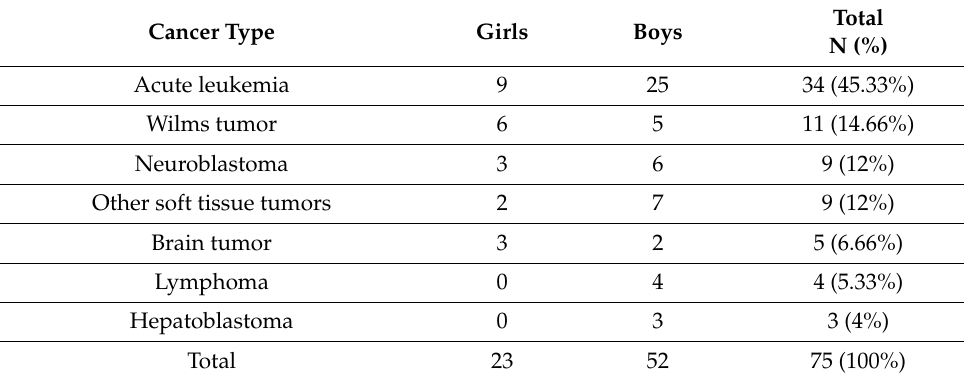
Table 1. Distribution of cancer diseases among